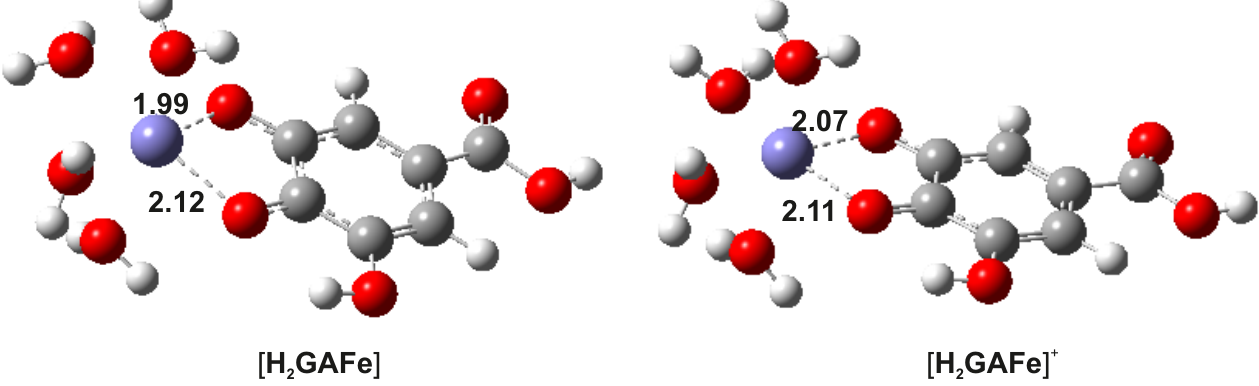
Figure 10. Optimized geometries of the most stable octahedral 1:1 complexes of Fe(II) (left) and Fe(III) (right) ions with H 2 GA 2 − gallic acid protonation species (bond distances are given in